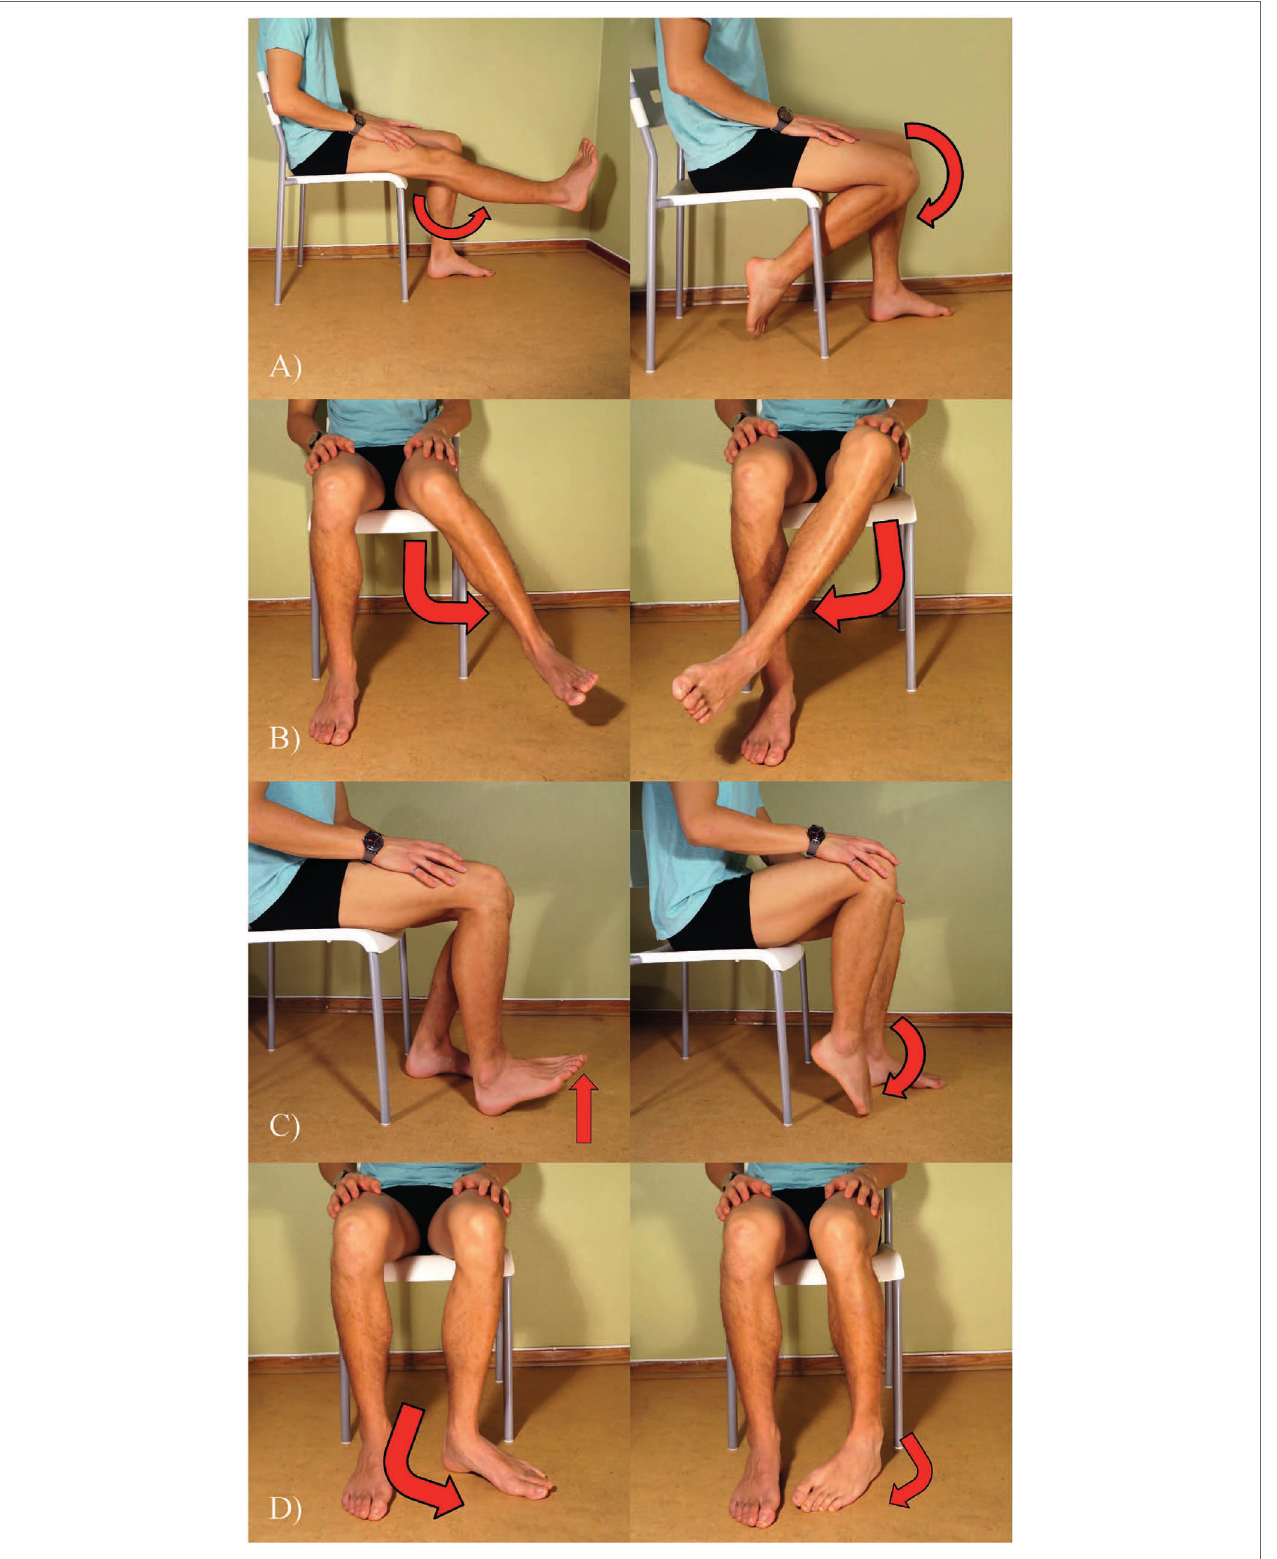
FigUre 2 | Photographs depicting the trained motions (a) knee extension and flexion, (B) femoral rotation outwards and inwards, (c) ankle plantar flexion and dorsiflexion, and (D) and tibial rotation outwards and